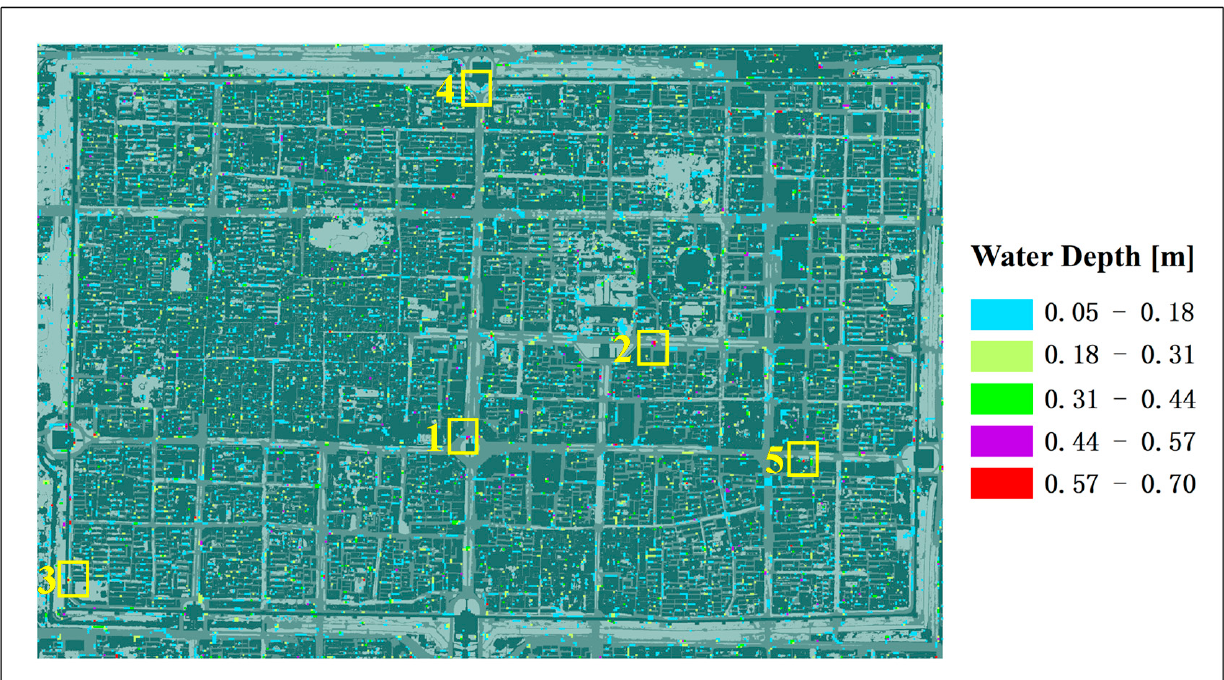
Figure 7. Distribution of the maximum inundation depth of the “20160724” rainstorm.